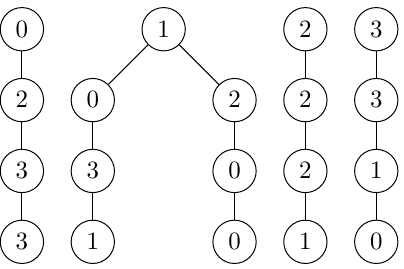
Figure 4: Worst-case scenario example with parameters K = 5 and b =